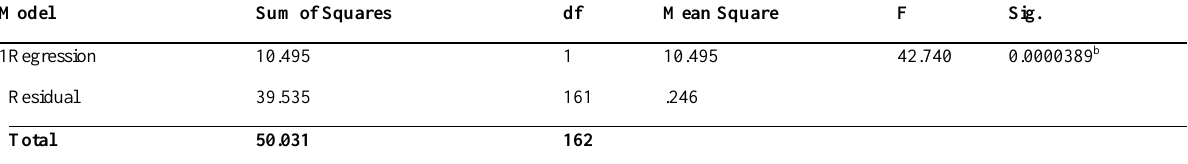
Table 7: Test of model fitness for predicting monitoring and evaluation and sustainability of donor funded livelihood projects Model